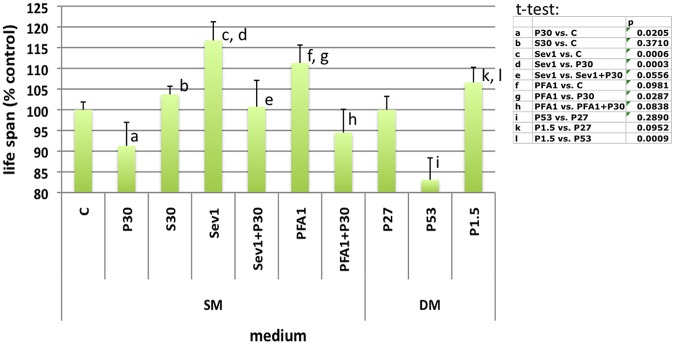
Phosphate supplementation or inhibitors of phosphate uptake influences adult life span.Median life span of adult y w males cultured on standard medium (SM): Control (C, n = 550), 30 mM sodium phosphate (P30, n = 465), 30 mM sodium sulfate (S30, n = 245), 1% sevelamer (Sev1, n = 207), 1 mM phosphonoformic acid (PFA1, n = 130), and the combinations: Sev1+P30 (n = 115), PFA1+P30 (n = 137), or defined medium (DM) supplemented with 1.5, 27, or 53 mM sodium phosphate (P1.5, n = 202; P27, n = 200; P53, n = 194). P<0.005 was used to test for multiple comparisons between eleven treatments.